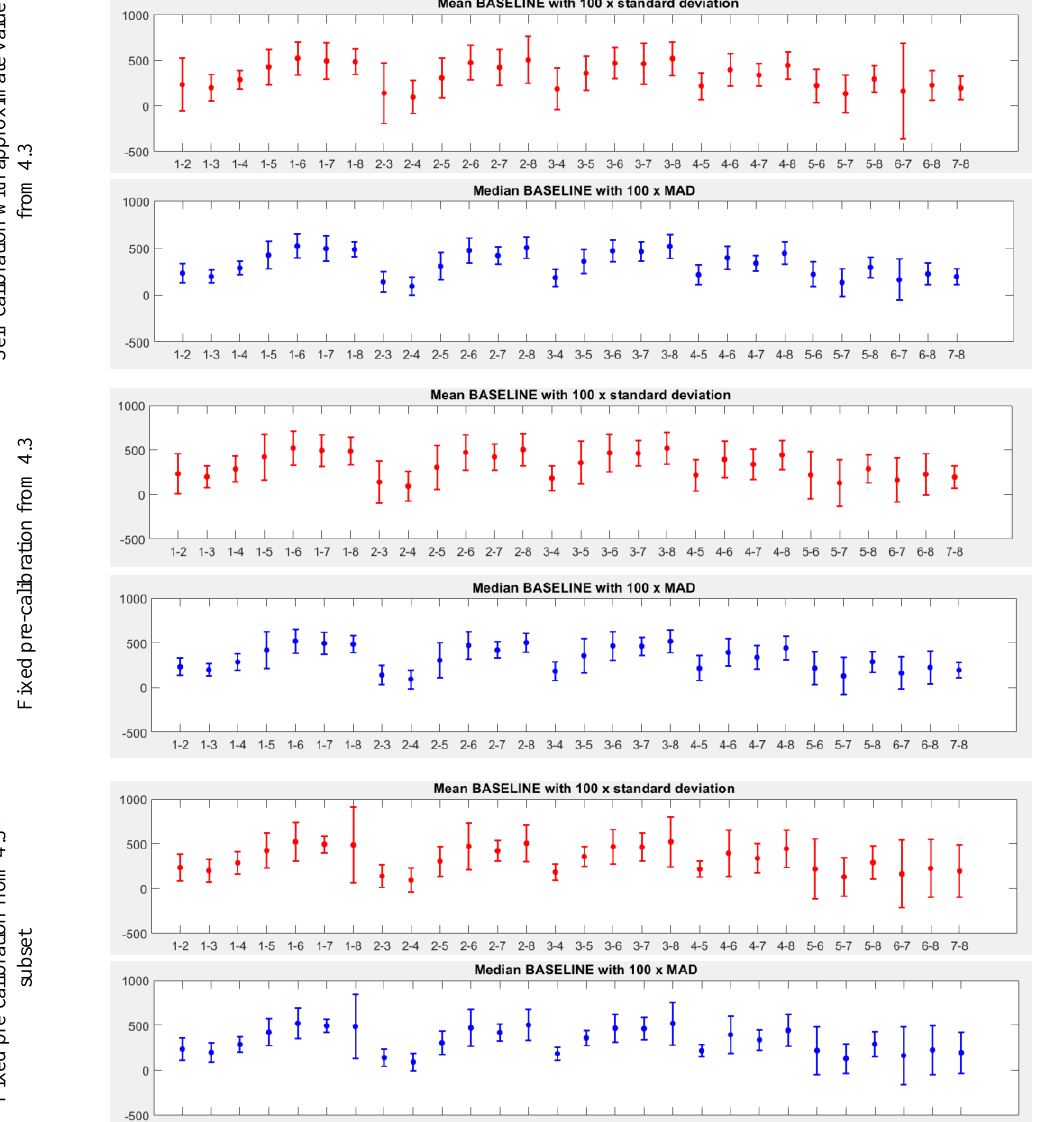
Figure 9. Mean and median baseline (lever arm) values (in mm) with the associated std and MAD (error scale = 100). The results are reported for the constrained solution.